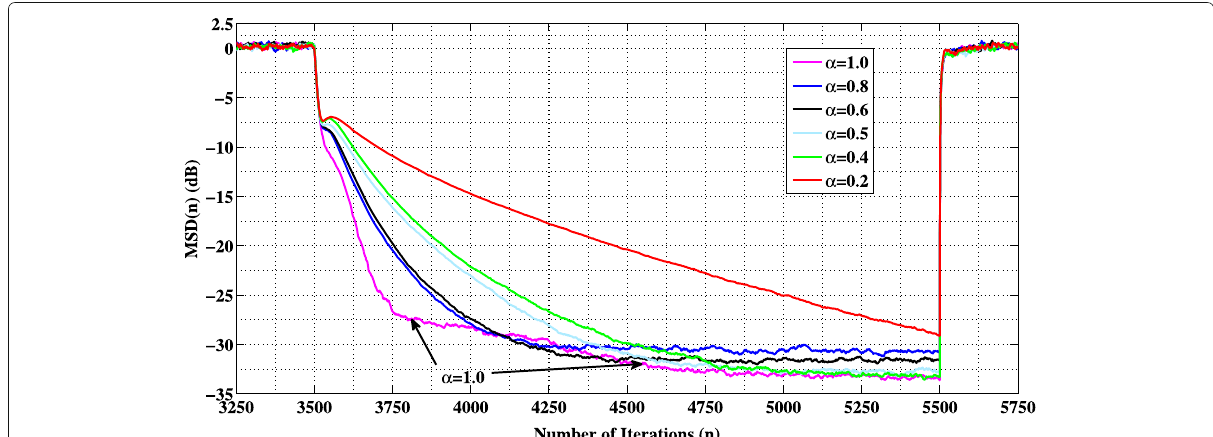
Fig. 16 Effect of coefficient transfer term on the MSD performance of the R-CFLF scheme when input signal is white noise